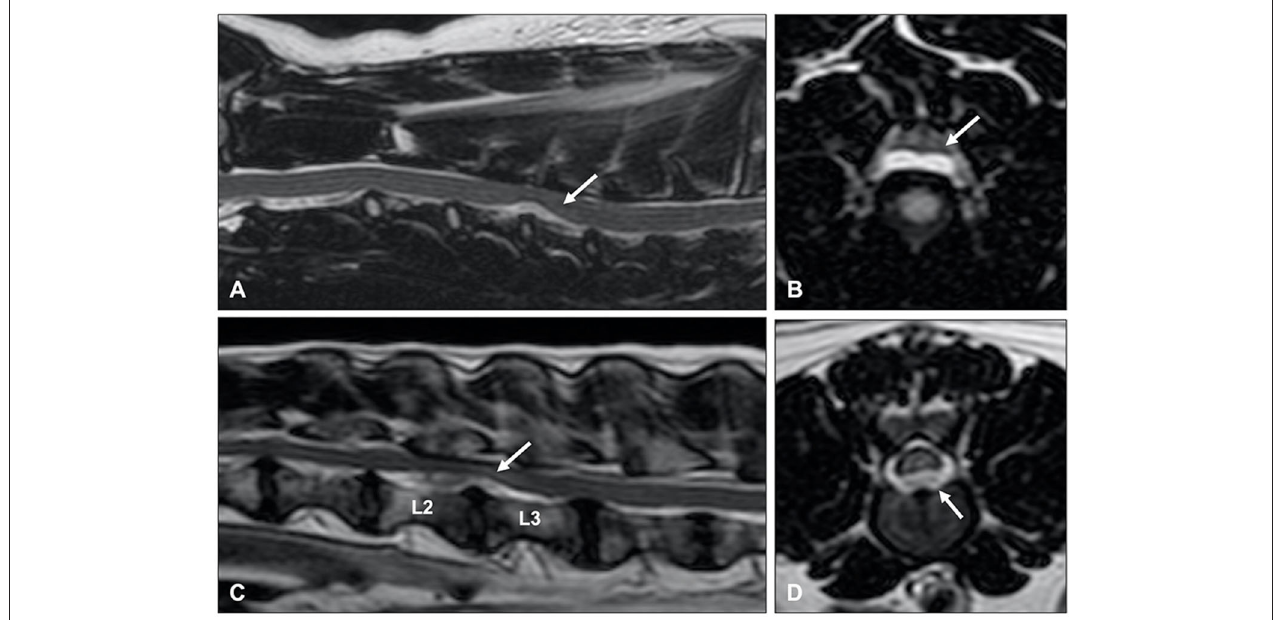
FIGURE 13 | T2-weighted (A) sagittal and (B) transverse MR images of a 6-year old Border collie with a C4-C5 HNPE. The intervertebral disc space is narrowed and contains a reduced volume of hyperintense nucleus pulposus. There is a ventral extradural homogenously hyperintense compressive lesion. (B) The compressive material is midline and has a bilobed, “seagull” appearance. T2-weighted (C) sagittal and (D) transverse images of 7-year old Beagle with acute onset paraplegia. Although HNPE occurs most often in the cervical region, this dog was diagnosed with an L2-L3 HNPE.